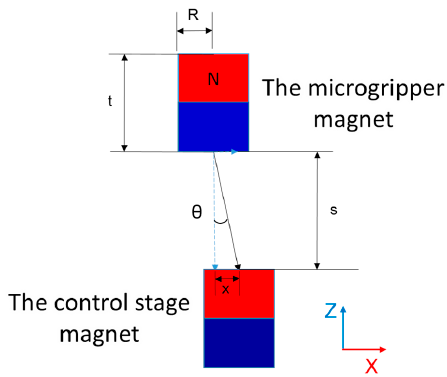
Figure 6. Actuation of the microgripper, triggered by the control stage magnet sweeping along the x axis. The relationship between the change in the magnets’ distance and the gap between the microgripper was examined experimentally, as shown in Figure 7a. The distance between the control stage and microgripper magnet was measured from the center of each magnet on the x axis (as shown) and gripper gap distance D was measured. Figure 7b shows that the rate of increase of D depends on the magnet position (specifically, the value of x). When a microrobot is driven by a permanent magnet beneath the glass substrate, there is a distance in which the microrobot does not follow the drive magnet; we named this distance the “dead band” [31] and it can be seen in the graph. The dead band is caused by the static friction of the microgripper with the glass substrate. This shows that there is a hysteresis caused by the dead band between the gripping phase and release phase in Figure 7b.